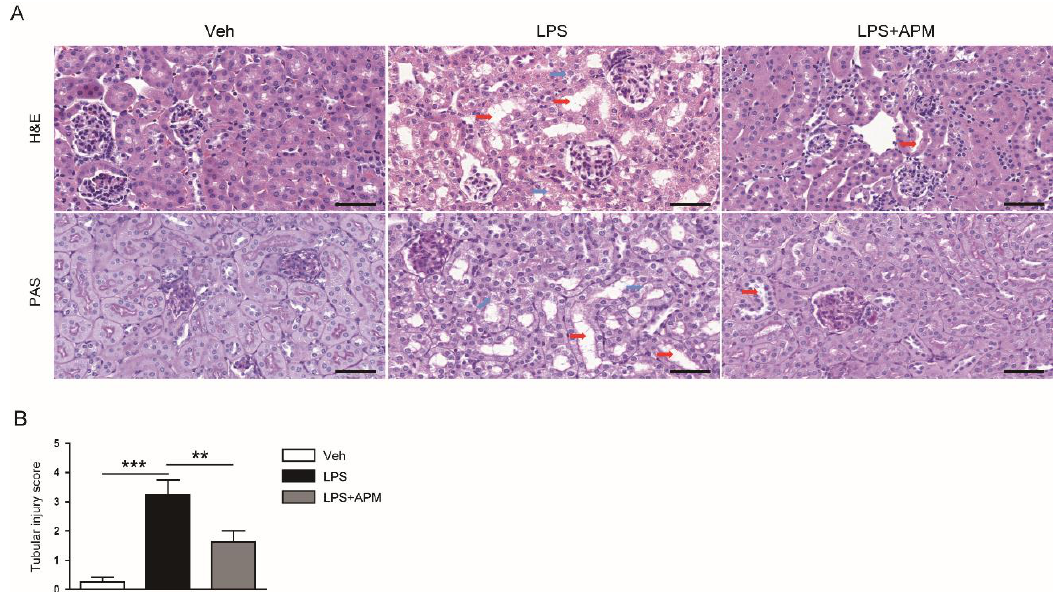
Figure 2. Histological examination of kidneys from all experimental groups. ( A ) Hematoxylin and eosin (H&E) and periodic acid Schiff (PAS) staining of kidney tissues. Red arrows indicate dilated tubules. Blue arrows indicate swelling of tubular epithelial cells. Scale bars: 50 μm. ( B ) Tubular injury score. n = 8 per each group. ** p < 0.01 and *** p < 0.001.